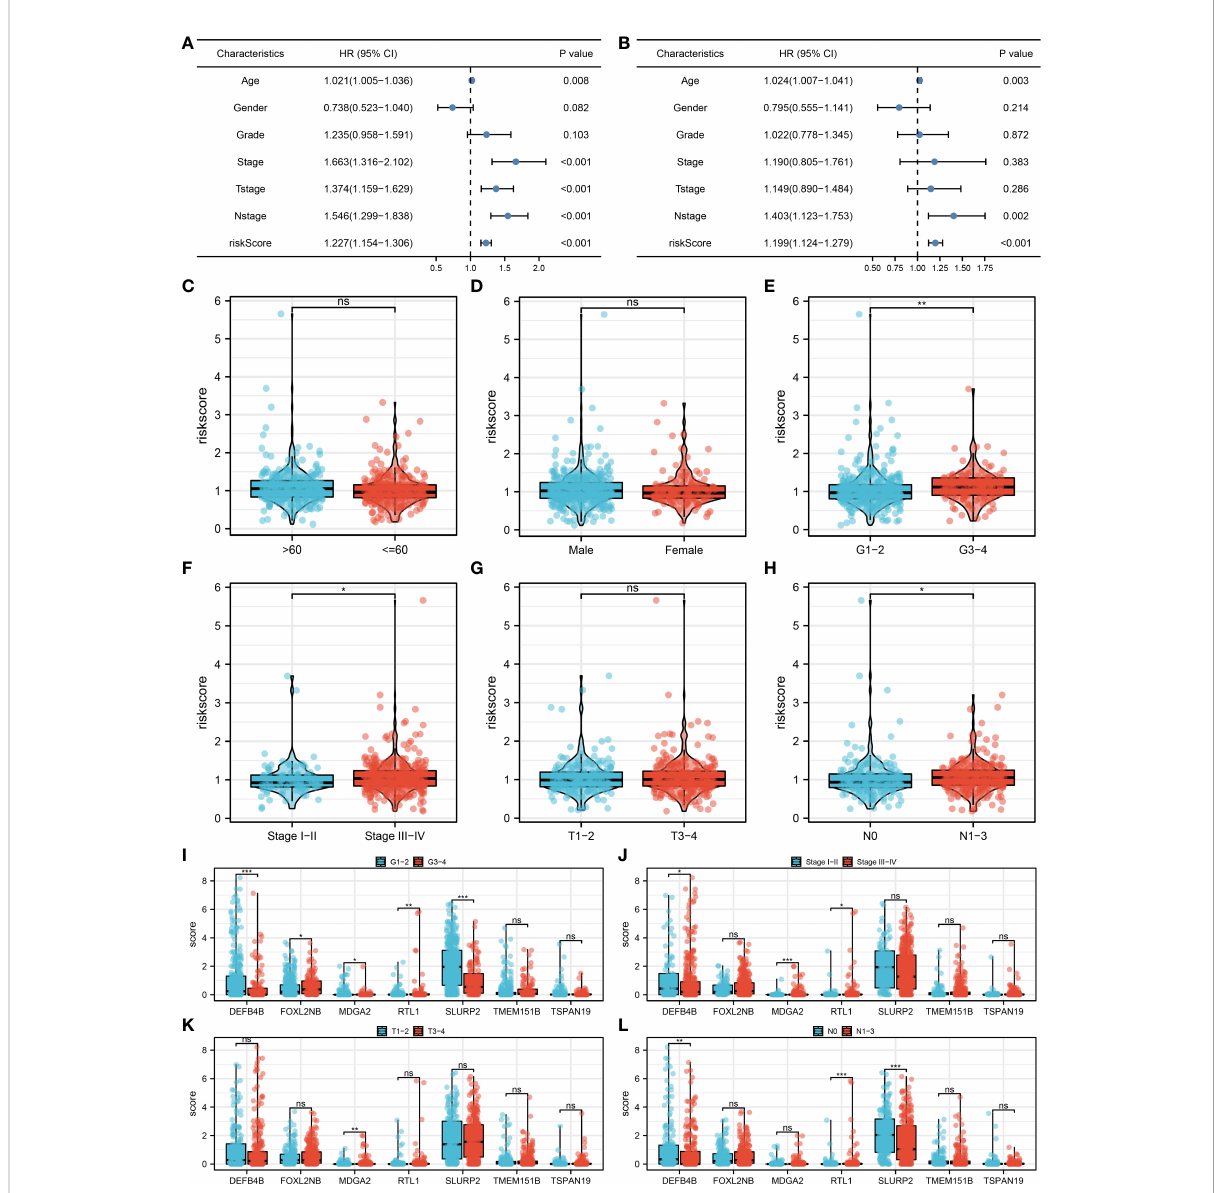
FIGURE 4 Clinical correlation analysis. (A) Univariate analysis was performed to evaluate the independence of our model; (B) Multivariate analysis was performed to evaluate the independence of our model; (C – H) The riskscore difference between patients with different clinical features; (I – L) The expression difference of model genes in patients with different clinical features. *P < 0.05; **P < 0.01; ***P < 0.001; ns. P >